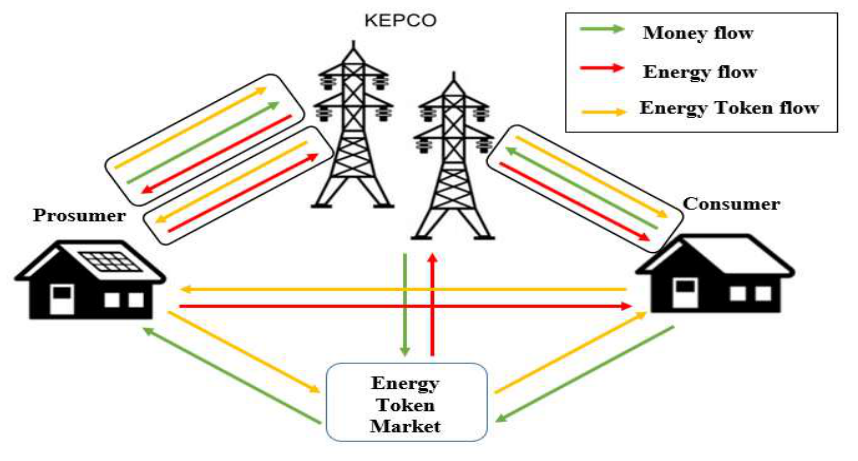
Figure 3. A P2P Figure 3. A P2P ETP. Figure 3. A P2P ETP.